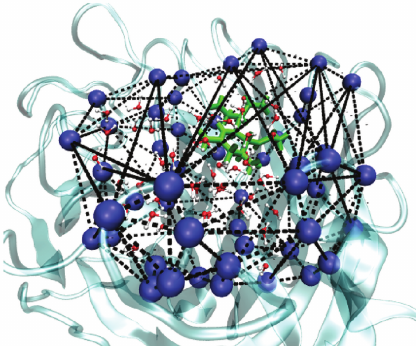
Figure 2: The construction of convex hull for the binding site. C 𝛼 atoms of fifty residues which define the binding pocket are shown in blue ball. Not all sides of polyhedron are shown. Oseltamivir is colored in green. Water molecules are also